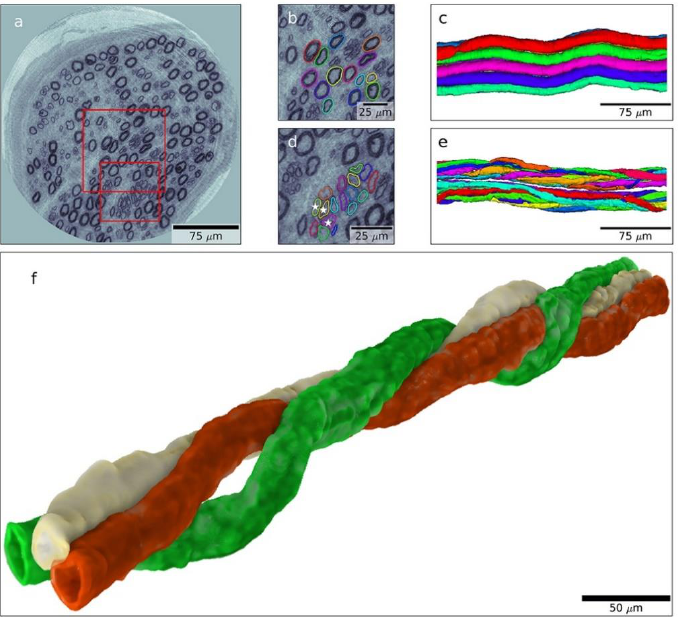
Figure 3. Nanotomogram with 3D images of a posterior interosseous nerve biopsy from an individual with type 1 diabetes. A tomographic slice ( a ) with an enlarged area ( b ) from which a 3D image is created with normal myelinated nerve fibres ( c ). Enlarged area ( d ) with a regenerative cluster, i.e., regenerating nerve fibres ( e ), and with details of such a regenerative cluster ( f ), showing spiral-shaped nerve fibres that have regenerated. Length of bar indicated in the figure. Reproduced by kind permission from Dahlin et al., Scientific Reports 2020